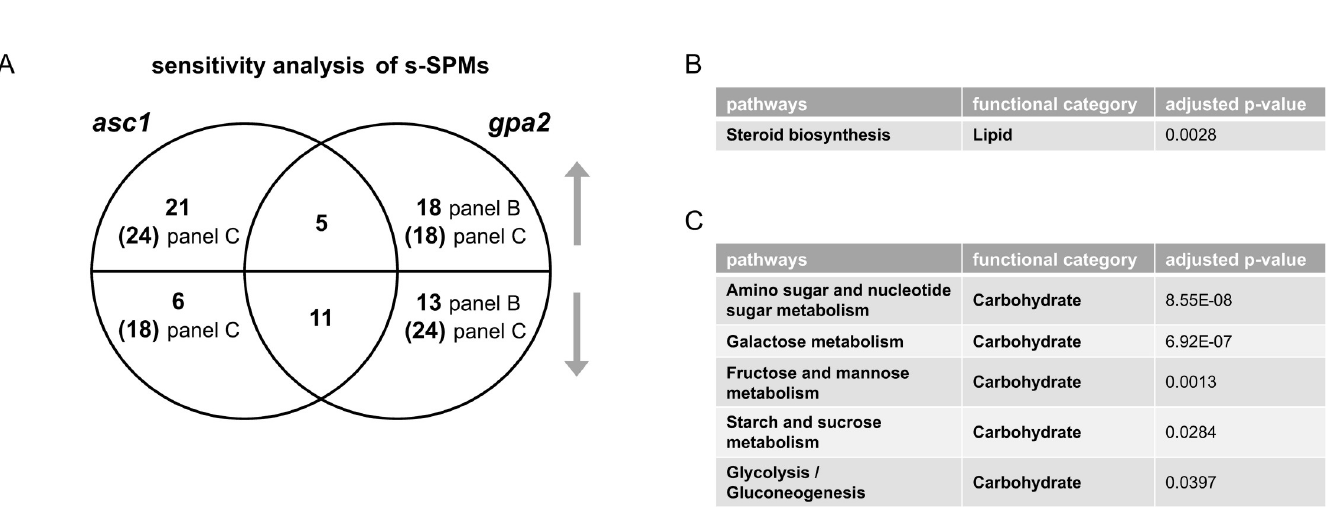
PLOS Genetics | https://doi.org/10.1371/journal.pgen.1009640 July 2,